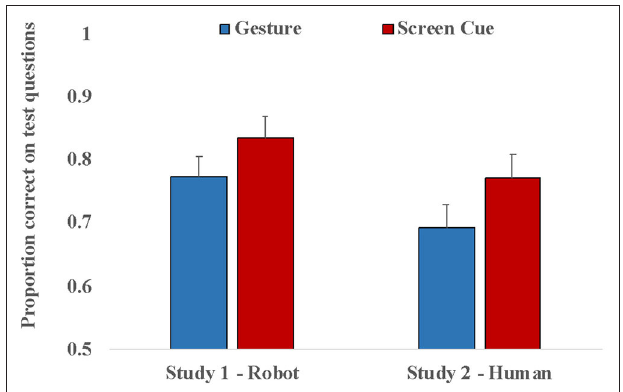
FIGURE 4 | Accuracy on the test as a function of Scaffold Type (Gesture, Screen Cue) and Tutor (Robot,